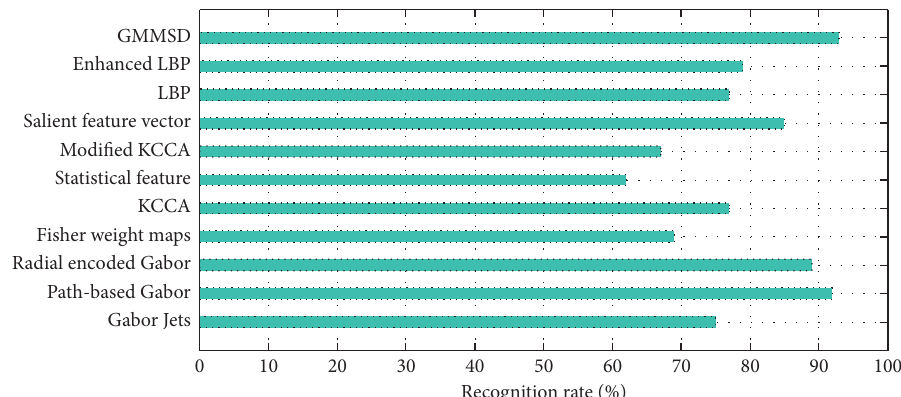
Figure 7: The recognition rate of different algorithms in the Jaffe face